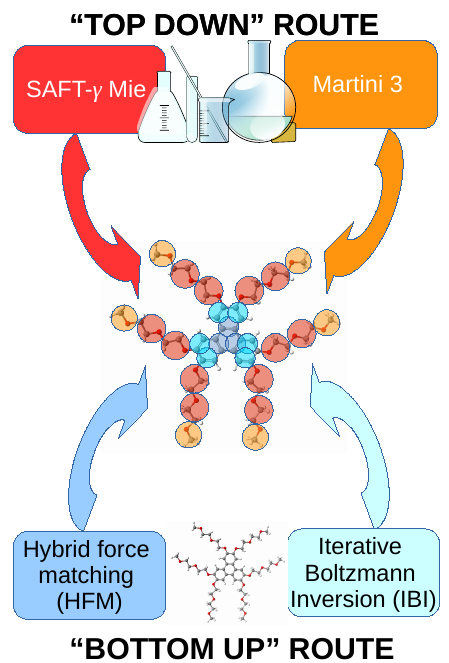
Figure 9. Routes to an ideal (“Goldilocks”) coarse-grained model for chromonic mesogens using both bottom-up and top-down methodologies; ideally producing a model that is “just right” for molecular simulation. A Goldilocks model would capture the correct self-assembly behaviour in solution in terms of the structure of aggregates and the thermodynamics of self-assembly and would be sufficiently transferable to be used successfully over a range of concentrations and temperatures (providing of course these were not too “hot” or too